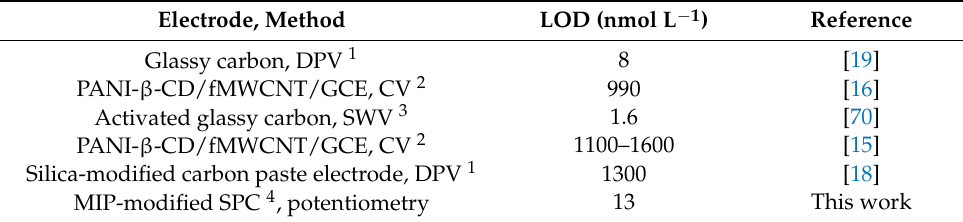
Table 1. Detection limits of different electroanalytical methods for MCPA analyses.